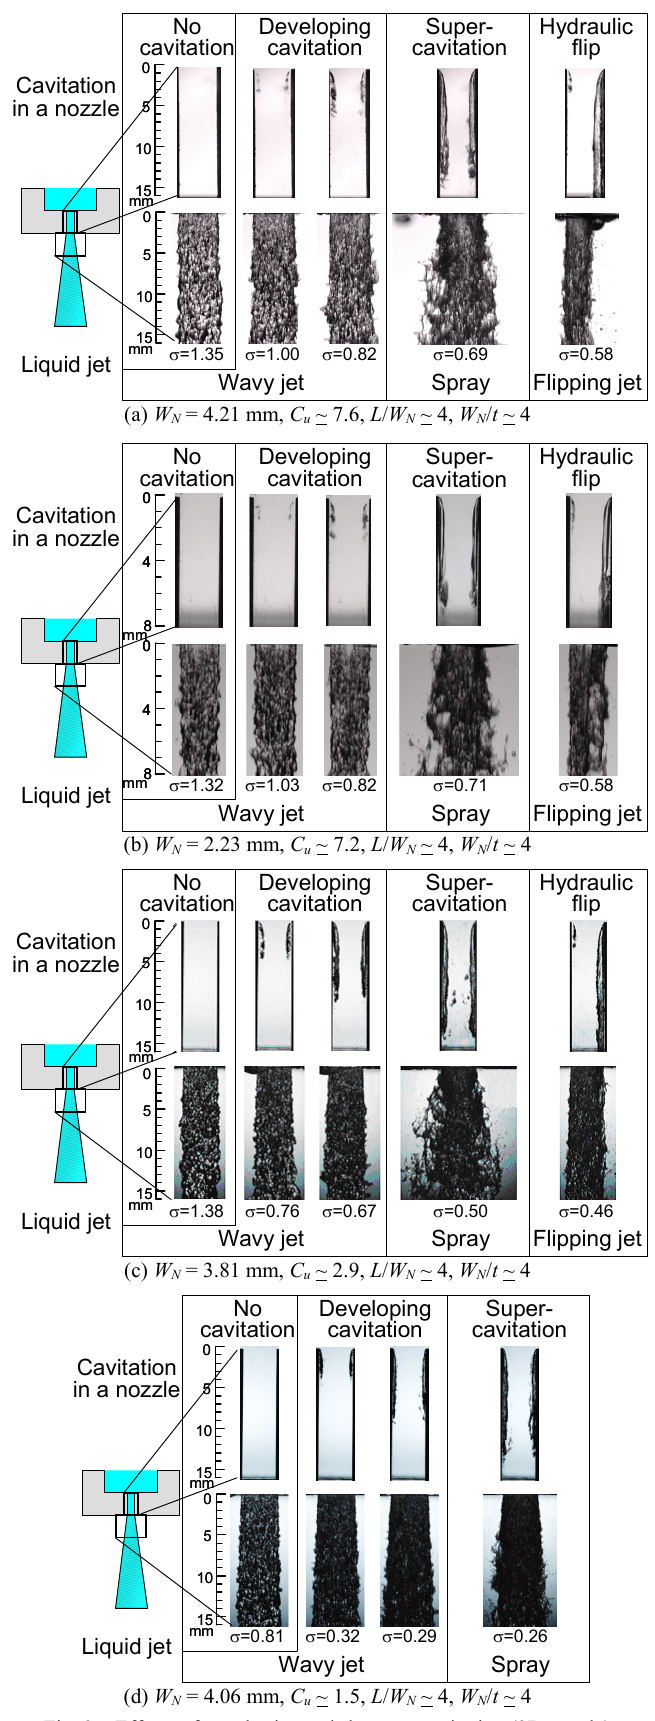
Fig. 3 Effects of nozzle size and shape on cavitation (2D